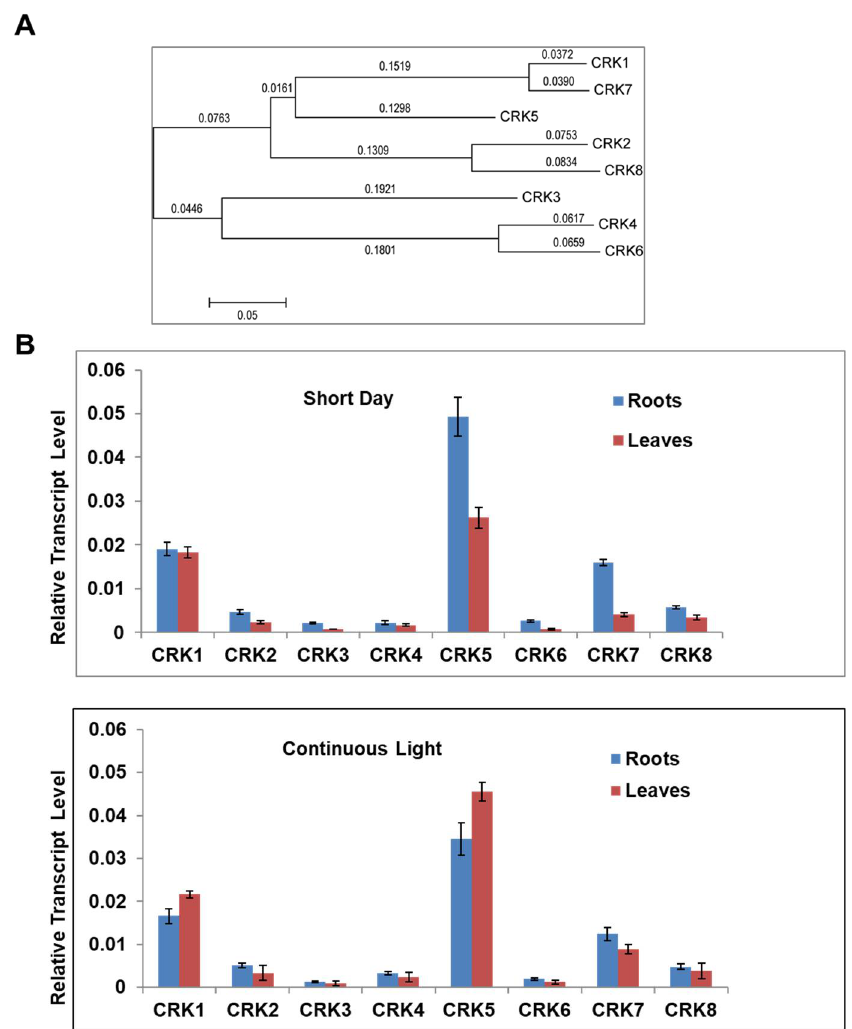
Figure 1. Relationship and expression of the AtCRK genes. ( A ) Phylogenetic tree of AtCRK proteins, using MEGA5.05 software, http://www.megasoftware.net/software. Bootstrap values are indicated. During phylogeny reconstruction, we used a neighbor-joining bootstrap method with 500 bootstrap replications; ( B ) AtCRK expression in wild type Arabidopsis sp. plants. Transcript levels were determined in the rosette leaves and roots of 14 days old wild type Arabidopsis sp. plants at short day and continuous light conditions using qRT-PCR. Relative transcript levels were standardized to GAPDH-2 (At1g13440). Reactions were made in three replicates. Bars indicate standard deviation (SD) carried out with two biological repetitions.